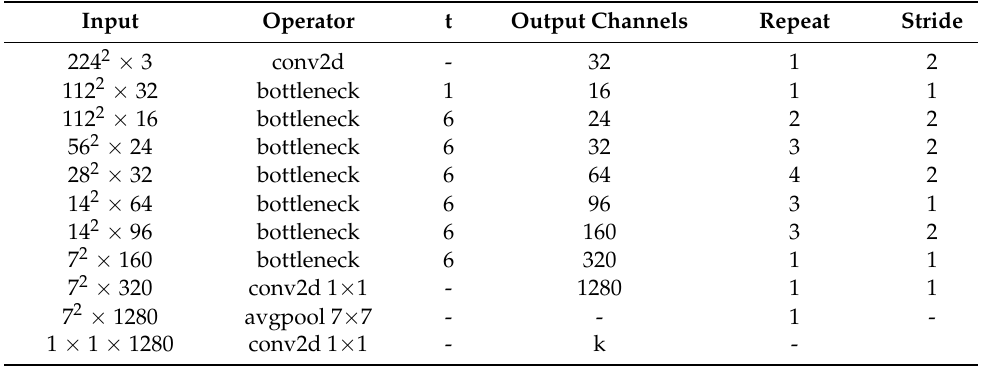
Table 3. MobileNet_v2 architecture